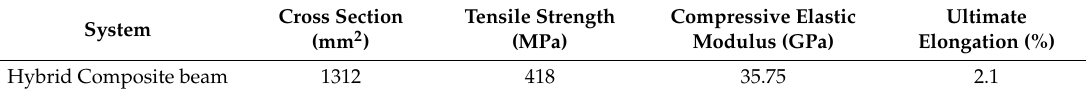
Figure 1. The hybrid composite beam (HCB) used. Table 1. Mechanical properties of the hybrid composite beam